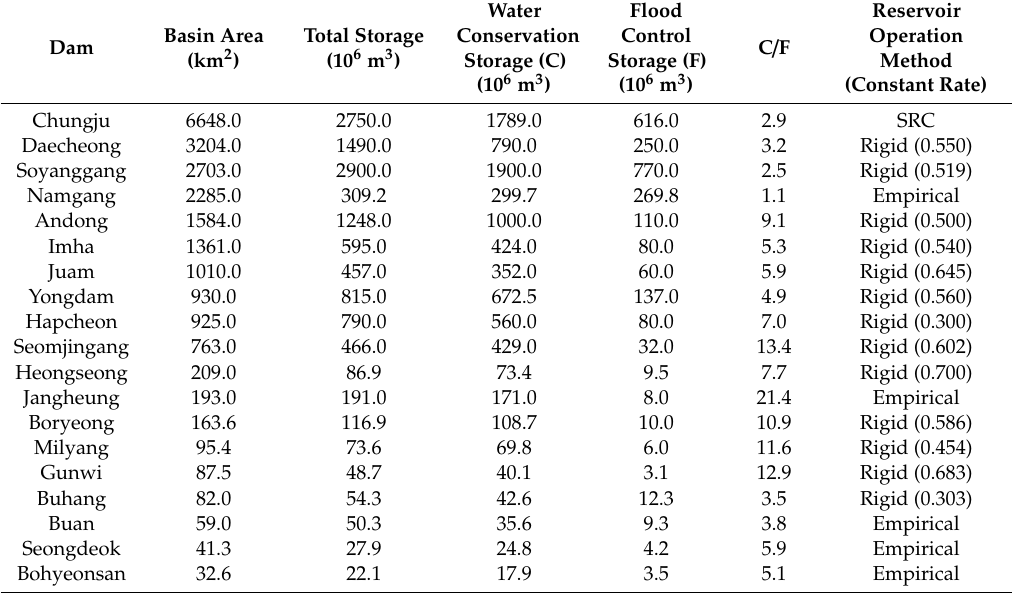
Table 1. Basic information of multi-purpose dams in Korea such as basin area, total storage, allocation of the water conservation storage and the flood control storage, reservoir operation method (ROM), and the constant rate for those dams operated by the Rigid